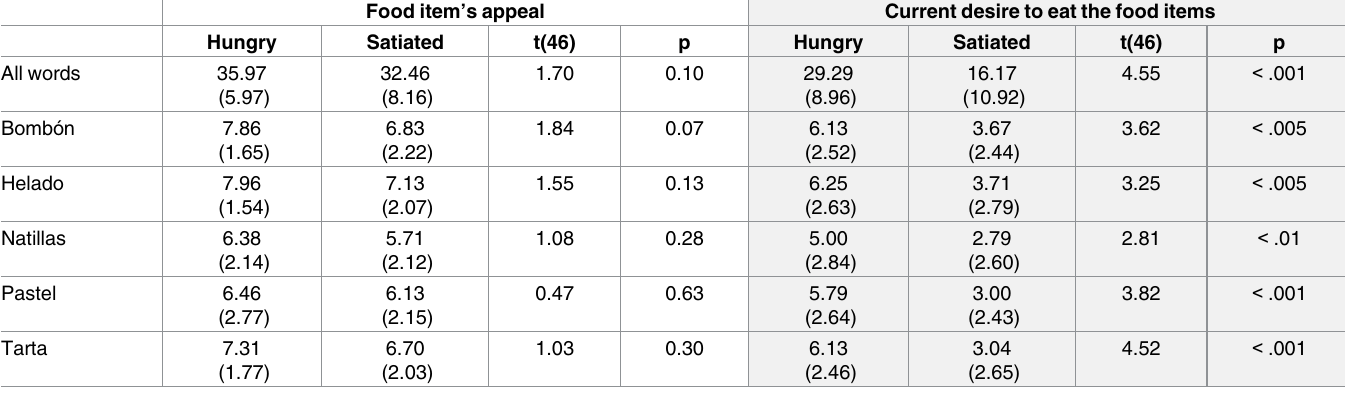
Table 4. Mean food item appeal ratings and mean desire to eat the food items ratings for hungry and satiated participants, with statistical compari- sons between these